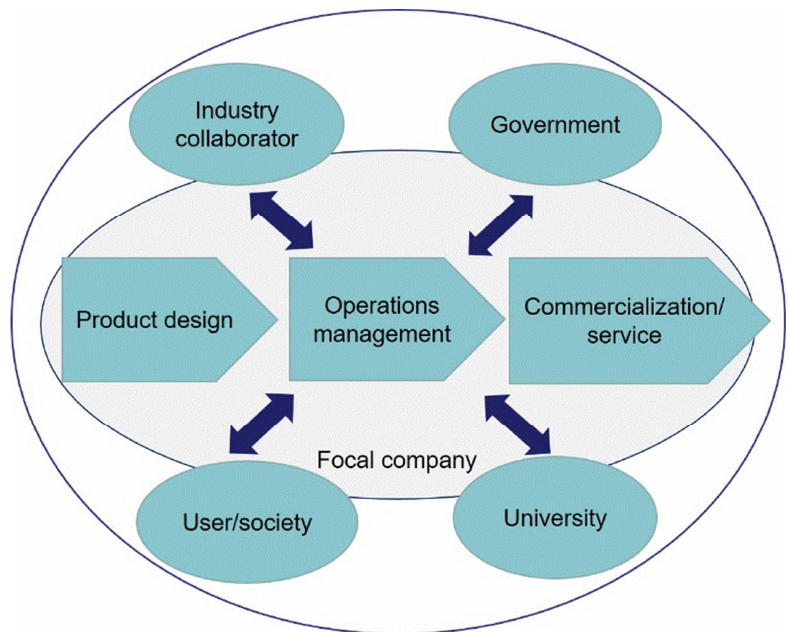
Figure 1. Responsible innovation of Hellobike within the value chain and business